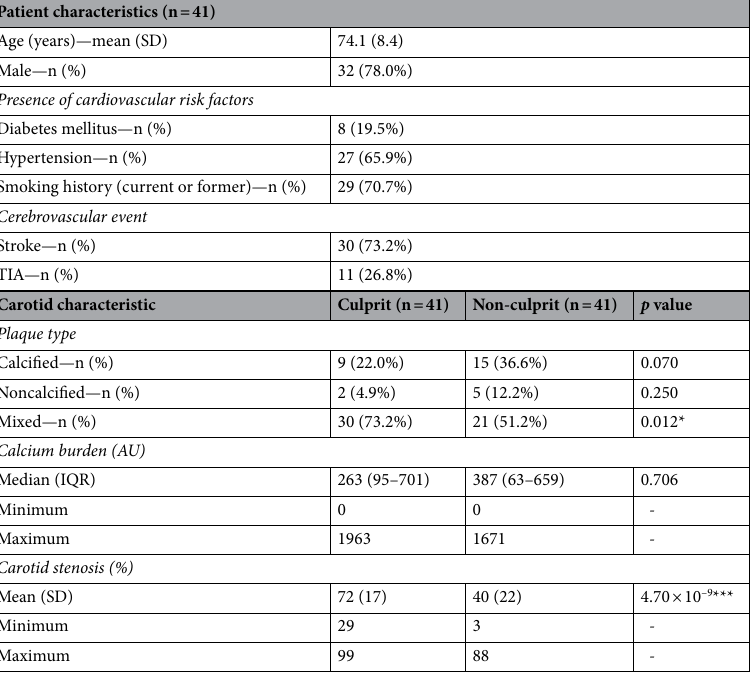
Table 1. Patient and culprit versus non-culprit carotid characteristics. Plaque type comparisons: McNemar’s test on paired proportions; Calcium score comparison: Wilcoxon signed-rank test; Carotid stenosis comparison: paired Student t-test. n, number of carotids or number of patients respectively; AU, Agatston units; IQR, interquartile range, SD, standard deviation; TIA, transient ischaemic attack; * p value < 0.05, *** p value < 0.001.